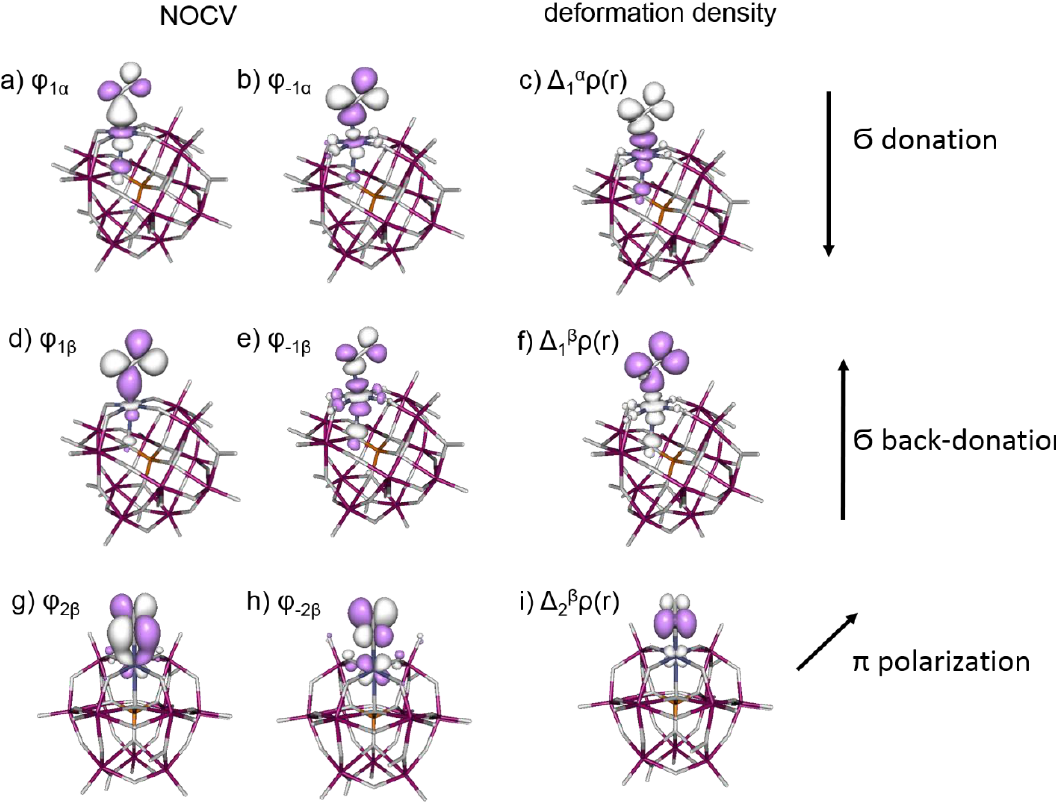
Figure 4. NOCV(pair for α electrons ( a , b ) and for β electrons ( d , e , g , h )) and the contribution to the deformation density ∆ ρ (r) ( c , f , i ) originated from the pairs of complementary of NOCV, characterizing the bond between the HPW(Mo) 11 Co fragment and OO ligand. The | ∆ ρ | = 0.05 a.u. contours are shown. White orbitals describe the outflow, and purple describes the inflow of electrons. Table 2. NOCV-eigenvalues describe the σ-donation, σ-backdonation, and π-polarization processes observed as a result of the interaction between the studied systems and the O 2 molecule.